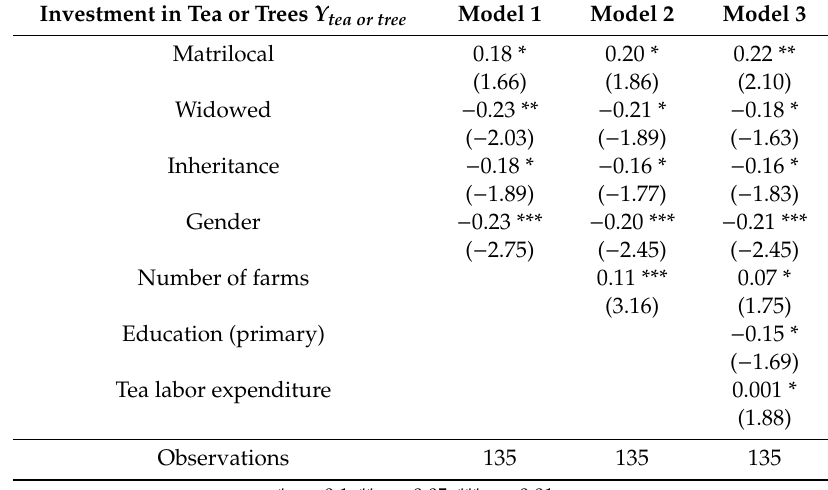
Table 4. Significant marginal e ff ects of variables on investment in tea or trees (Logit Equation (6)).